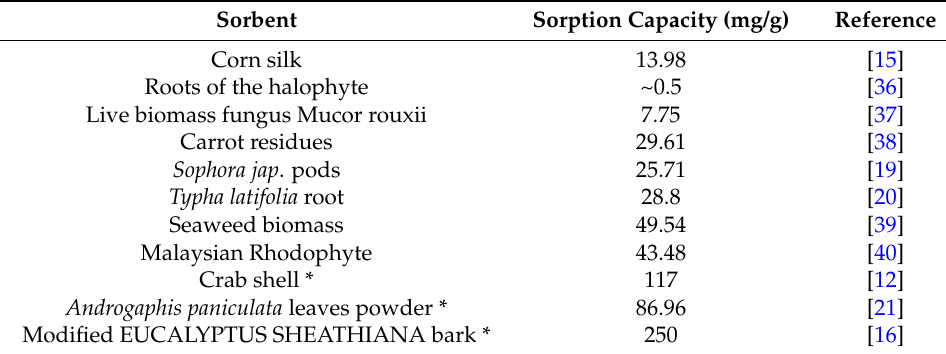
Androgaphis paniculata leaves powder * Modified EUCALYPTUS SHEATHIANA bark